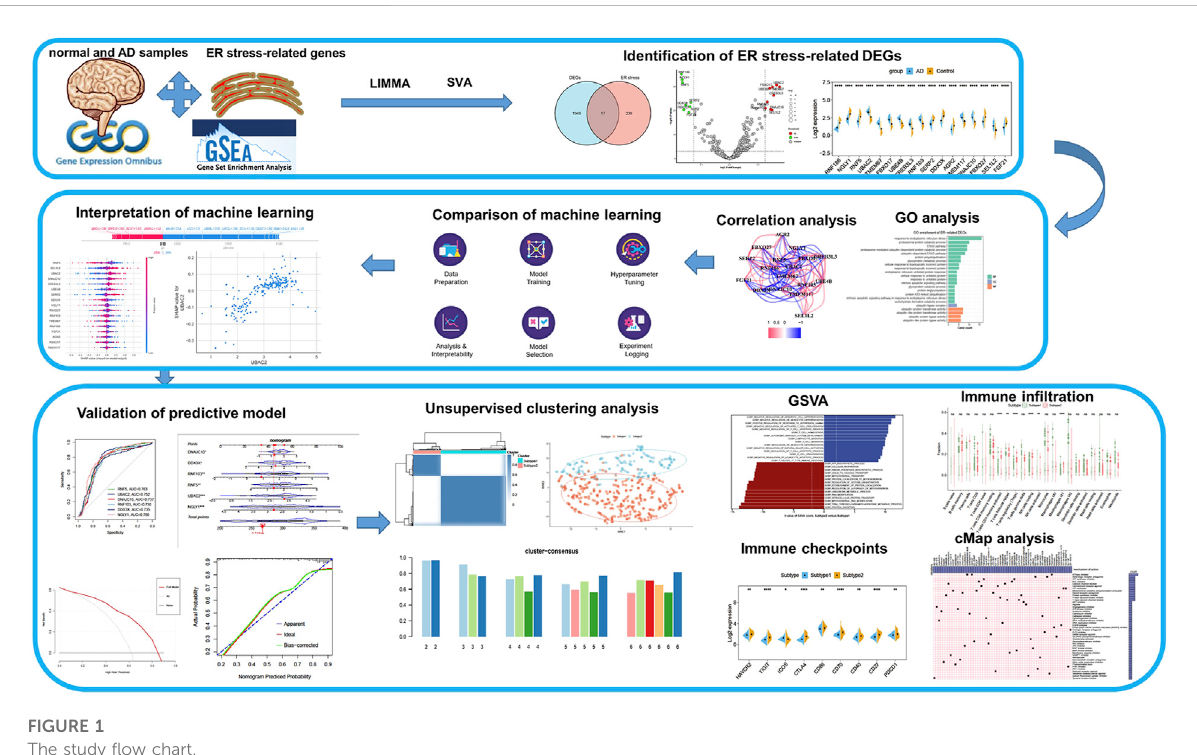
FIGURE 1 The study fl ow